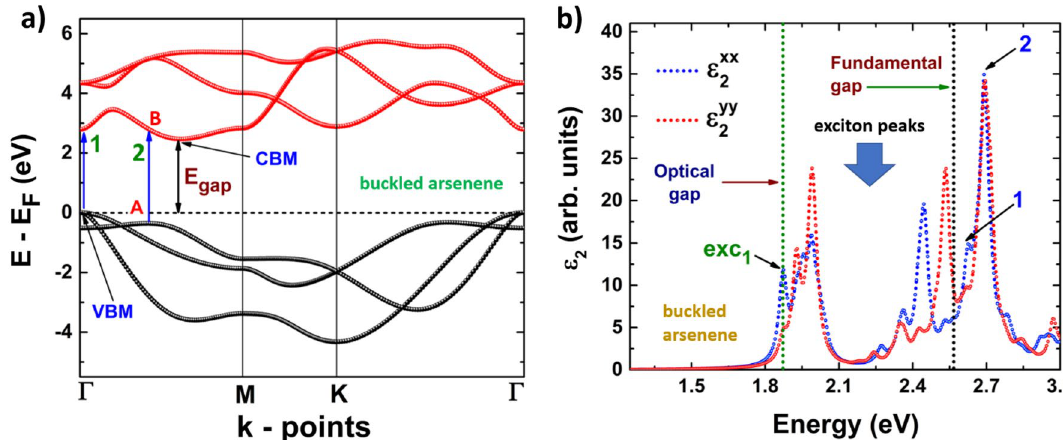
Figure 10. ( a ) Electronic band structure of buckled arsenene including the information of two important direct transitions. ( b ) Dielectric function imaginary part of buckled arsenene showing the values of the corresponding optical and fundamental gaps as well as exciton peaks. The peaks associated with direct transitions depicted in ( a ) are also included.